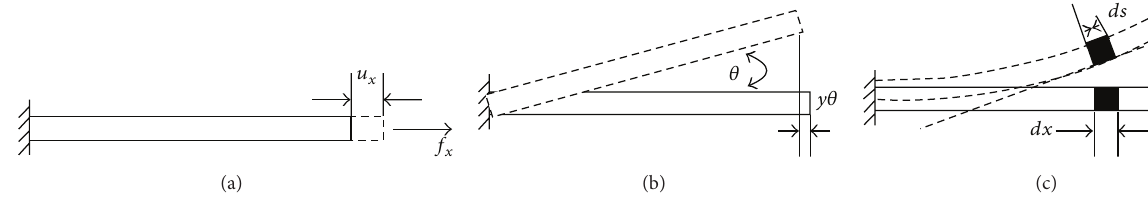
Figure 5: Longitudinal